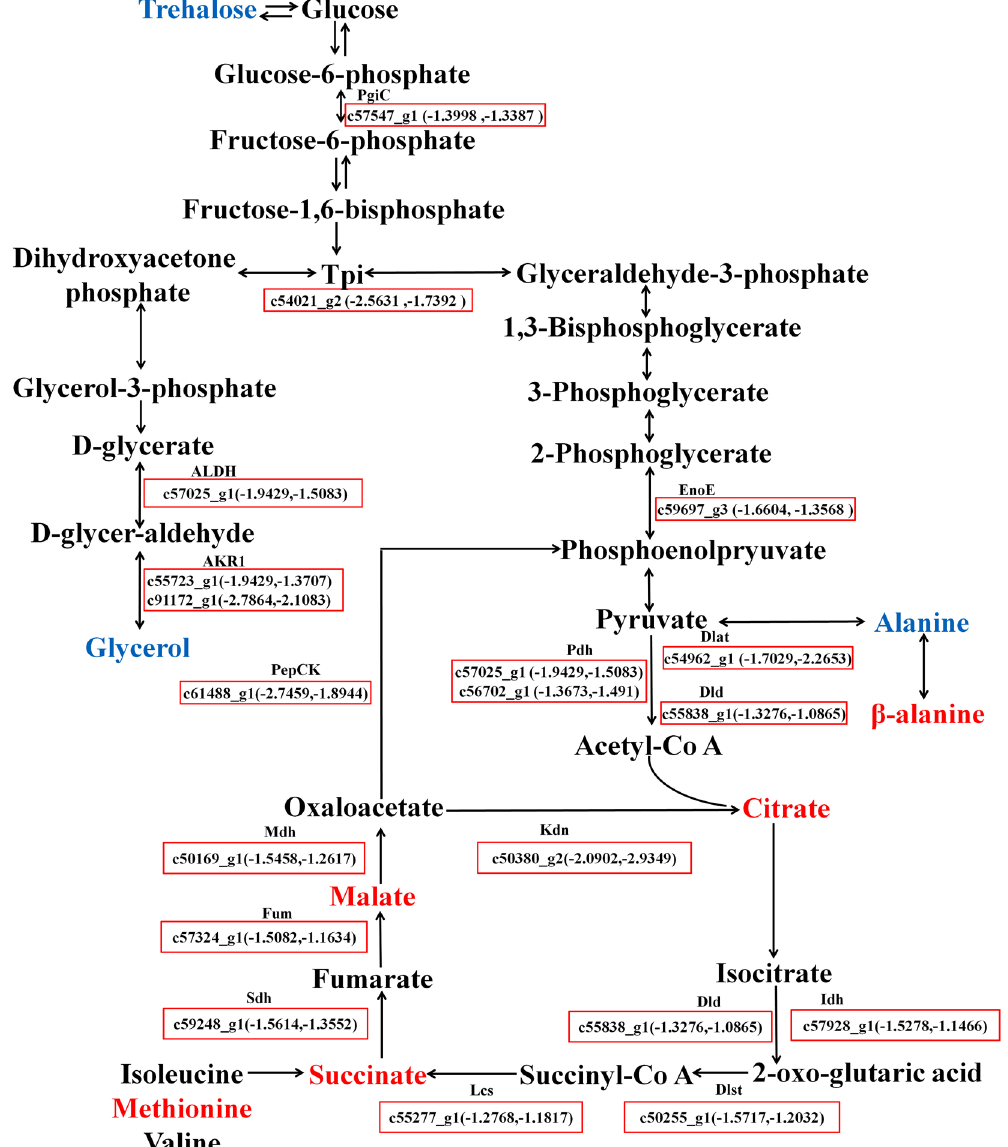
Figure 5. Genes involved in glycolysis/gluconeogenesis and TCA cycle were significantly repressed during dormancy. Names of enzymes are listed above the boxes, and the C. ciliata unigenes and log2 fold change values comparing dormant to non-dormant adults are listed within the boxes (First is the log2 fold change of dormant female vs non-dormant female, second is the log2 fold change of dormant male vs non-dormant male). Red boxes indicate DEGs that are significantly up-regulated in dormant compared with non-dormant adults with a q-value < 0.01. Metabolites in red text are significantly down-regulated in dormant adults relative to non-dormant adults. Metabolites in blue text are significantly up-regulated in dormant adults relative to non- dormant